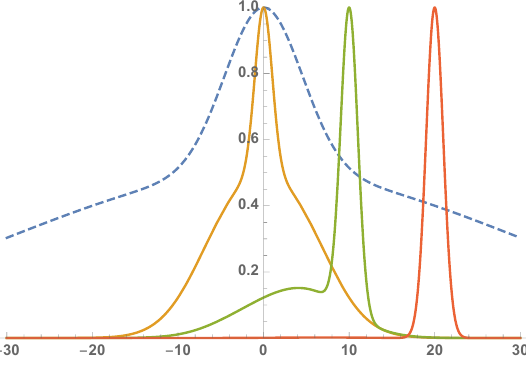
Figure 6. Normalized intensity (dashed curve), together with µ ( 0, x ) , µ ( 10, x ) and µ ( 20, x ) vs. x (from left to right) for the CSD in Equation (24), with σ 1 = 30, δ 1 = 1, δ 2 = 10, and σ 2 = 4.49.